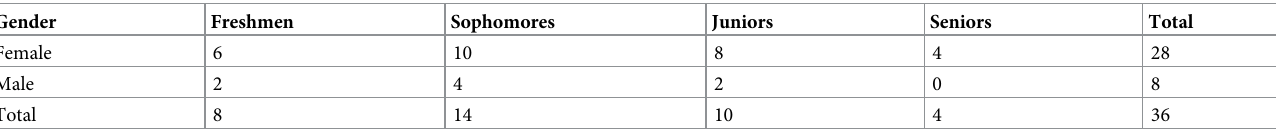
Table 3. Demographic information of participating